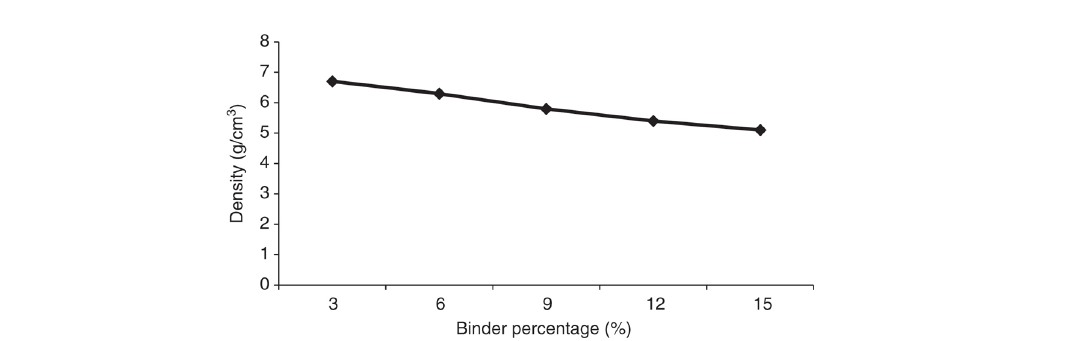
Figure 1: Density variation with changes in the organic binder percentage.